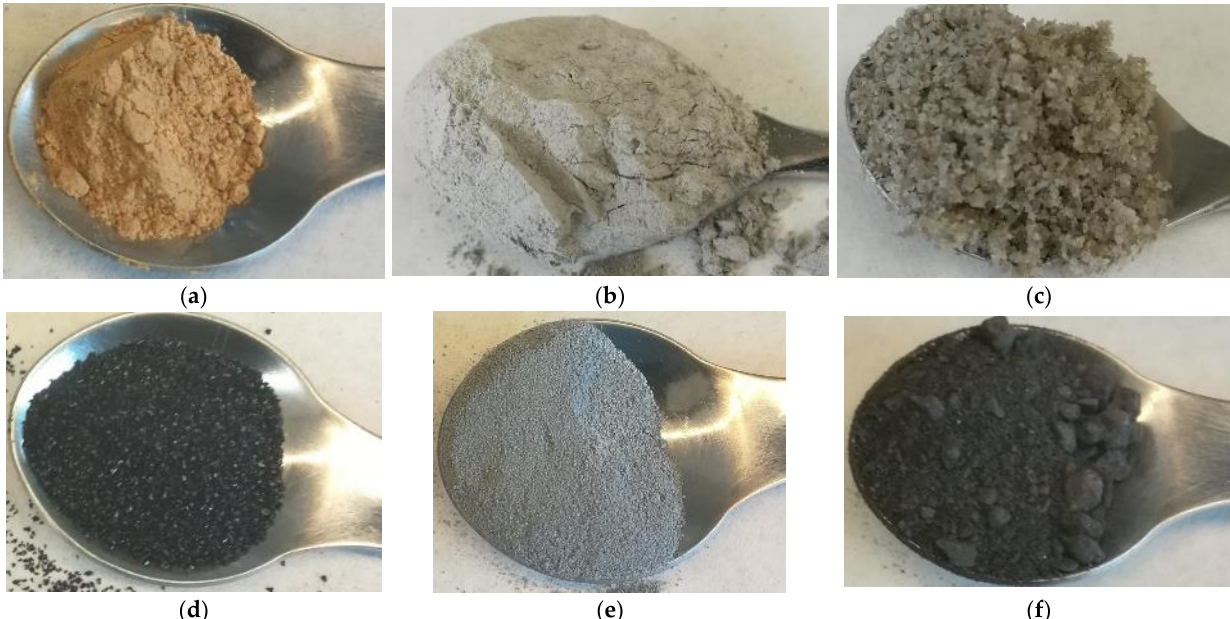
Figure 1. Supplementary cementitious materials used in this research. ( a ) bauxite, ( b ) chamotte, ( c ) ground granulated blast furnace slag, ( d ) iron silicate, ( e ) silica fume, and ( f ) steel slag. Bauxite is a sedimentary rock with high alumina (Al 2 O 3 ) content, used in aluminum Table 3. Chemical composition in wt % and physical properties of SCMs. Data provided by the suppliers.